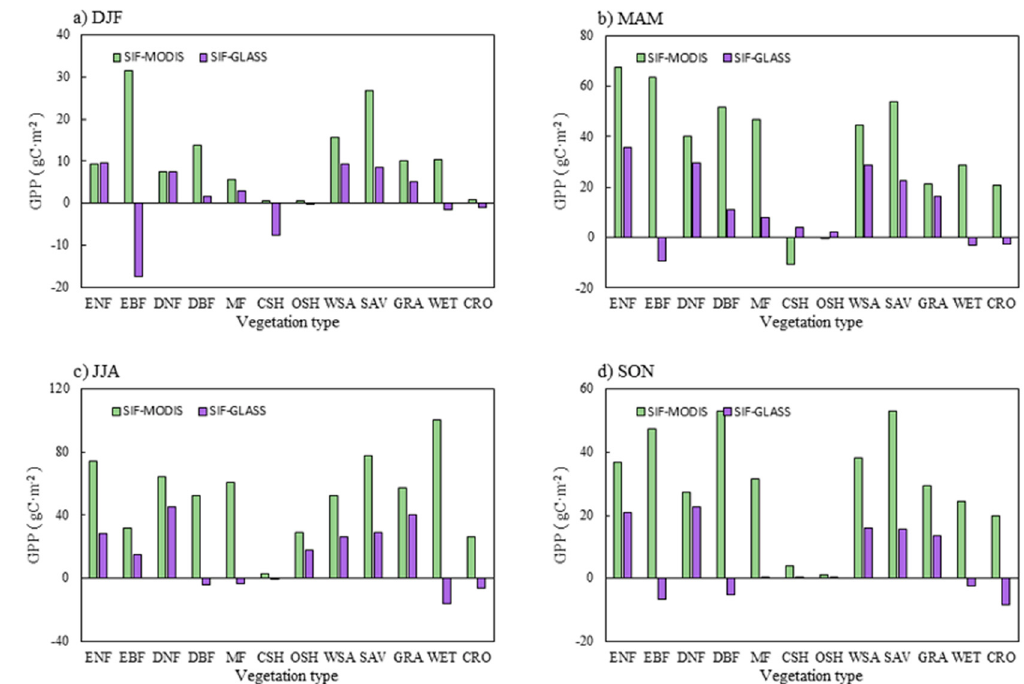
Figure 6. Differences in global GPP for all vegetation coverage types in different seasons in 2014 (green represents the difference between GPP SIF and GPP MODIS , purple represents the difference between GPP SIF and GPP GLASS ).